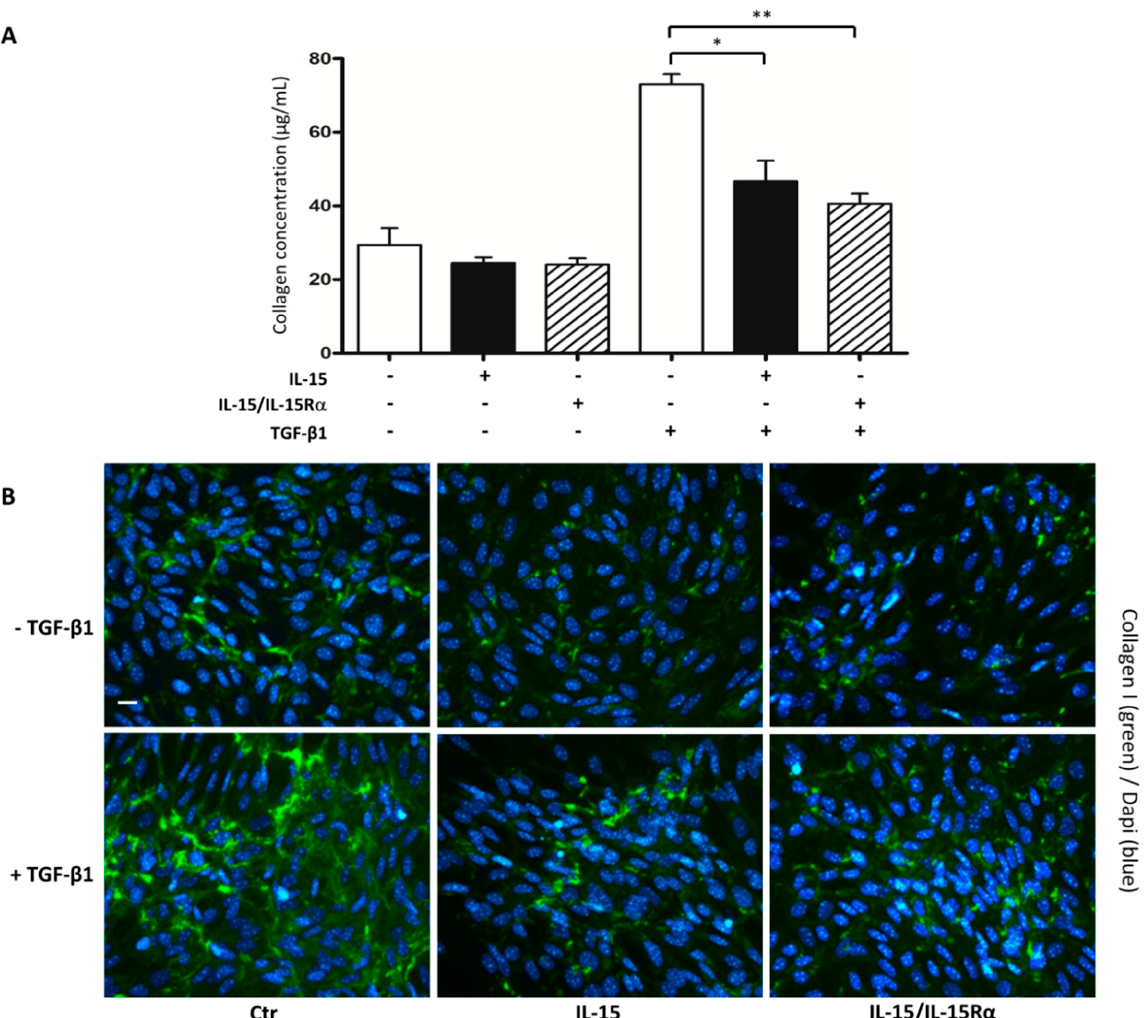
Figure 5. Both IL-15 treatments attenuated collagen synthesis and secretion induced by TGF- β 1 stimulation in myofibroblasts. Myofibroblasts were treated for 48 h with TGF- β 1 alone (2.5 ng/mL), IL-15 alone (2.5 ng/mL), or IL-15/IL-15R α (2.5 ng/mL IL-15 + 15 ng/mL IL-15R α -Fc). ( A ) The amount of collagen in 48 h treated myofibroblasts supernatants was quantified using the commercially Sirius Red collagen detection kit. Data are means ± SEM (* p < 0.05, ** p < 0.01, n = 3). ( B ) Immunofluorescent staining of collagen I expression (green) in 48 h treated myofibroblast cultures. Nuclei were stained with DAPI (blue). Representative images from three independent experiments are shown. Scale bars, 20 µm.